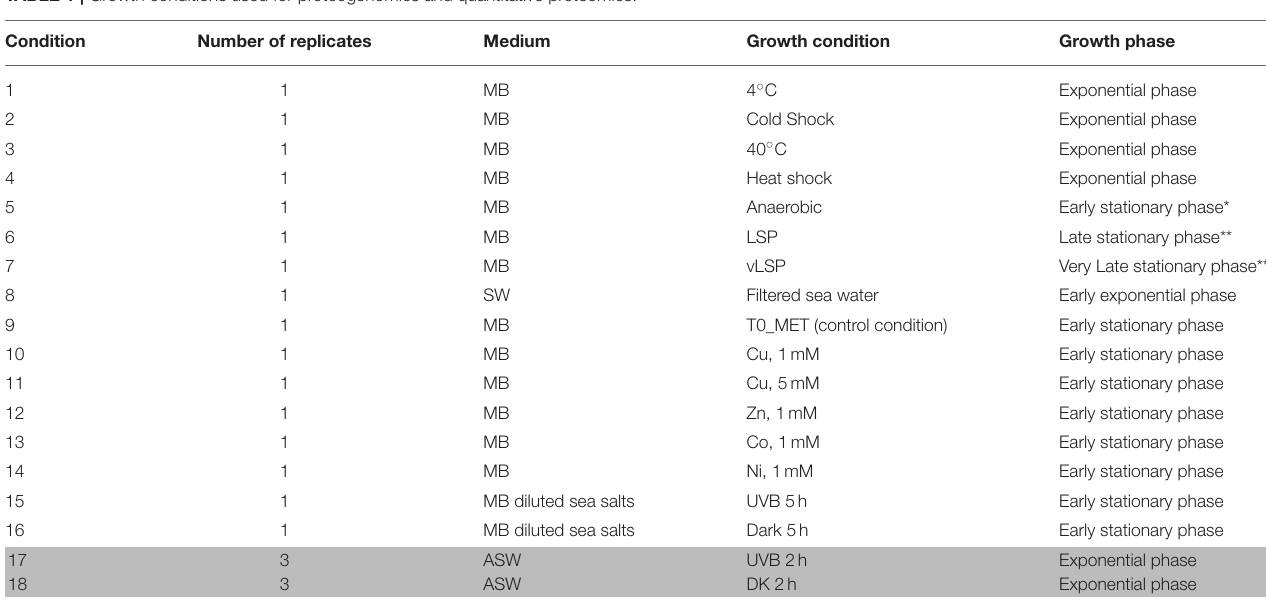
TABLE 1 | Growth conditions used for proteogenomics and quantitative proteomics.